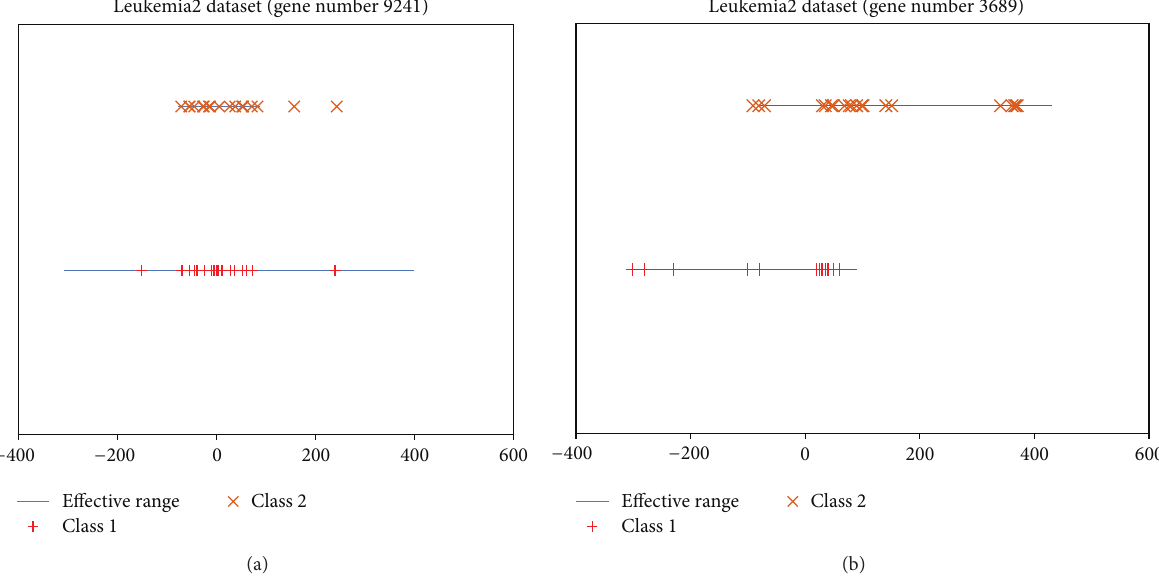
Figure 1: The ER of the gene accessions numbers 9241 and 3689 from the Leukemia2 gene database.